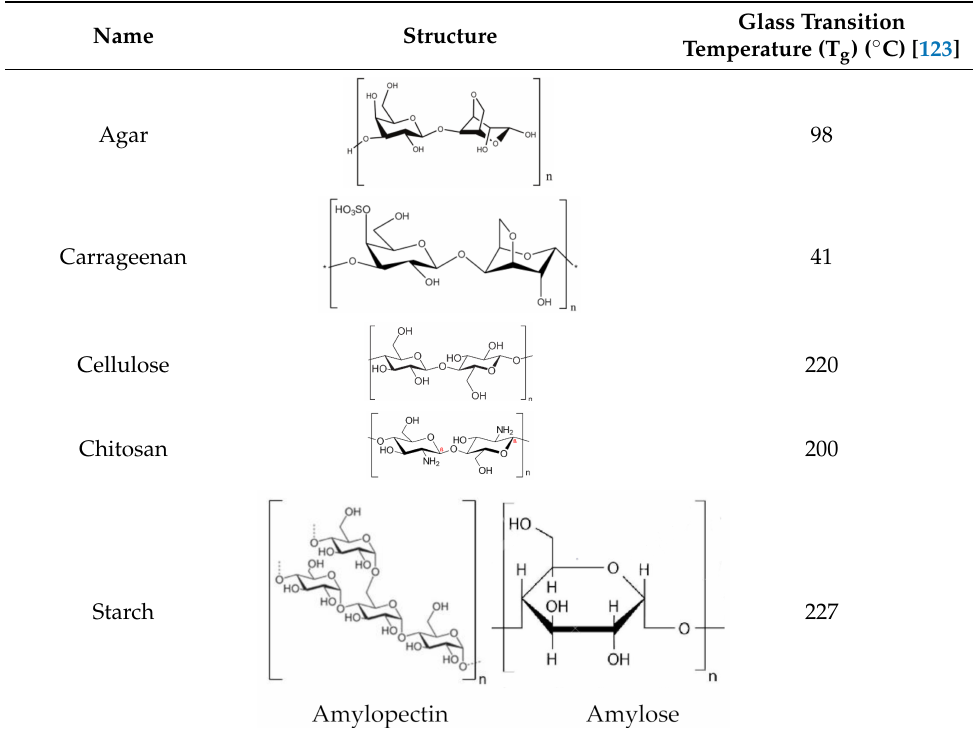
Table 7. Chemical structures of some biopolymers employed in nanocomposite polymer electrolytes